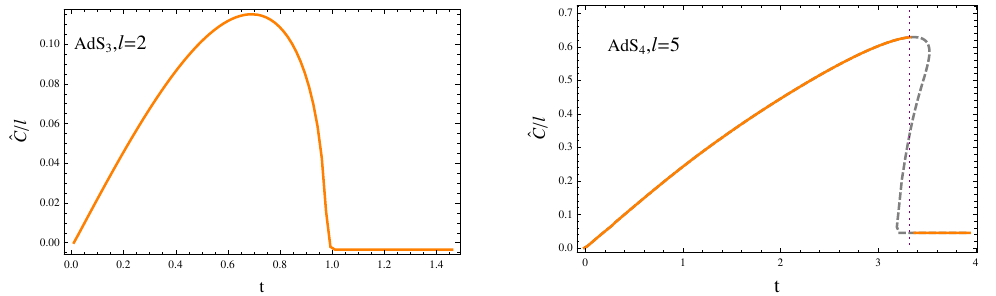
Figure 7 . The evolution of the subregion complexity density ^ C=l with respect to the boundary time t . We (cid:12)x M = 1 and v 0 = 0 : 01 here. The transition point in the right panel locates at t = 3 :